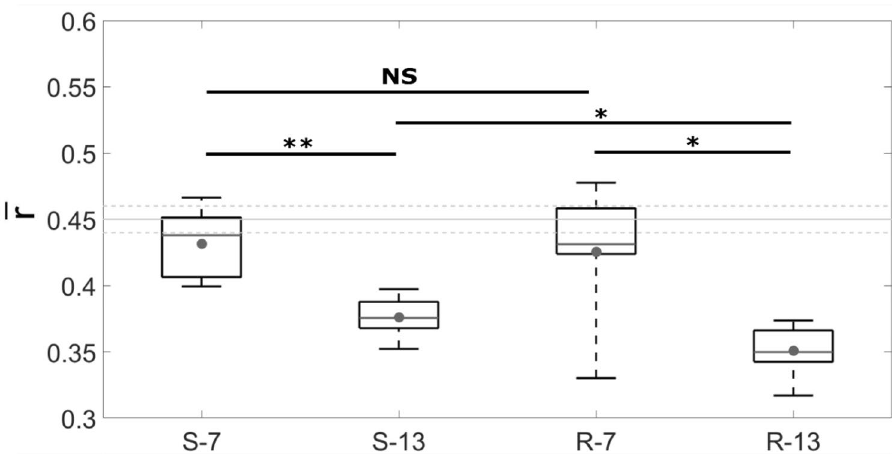
Figure 5. Averaged value of the ratio r ( r ) for the samples belonging to each group. The dots represent the mean value, the grey lines the median value, the bottom (respectively top) edges of the box the 25th (respectively 75th) percentiles and the whiskers extend to the most extreme data points. The light grey lines correspond to the average and standard deviation for intact implants. The Mann–Whitney U-tests lead to: * p value < 0.05; ** p value < 0.01; NS (non-significant difference) p value > 0.05.